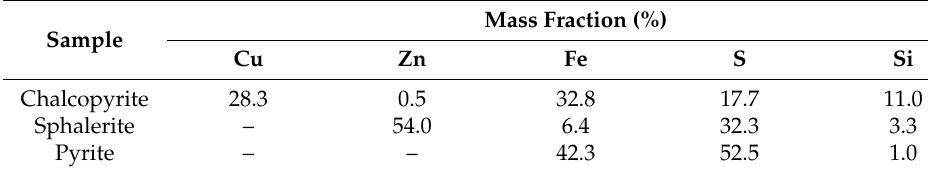
Table 1. The chemical composition of mineral samples based on XRF.